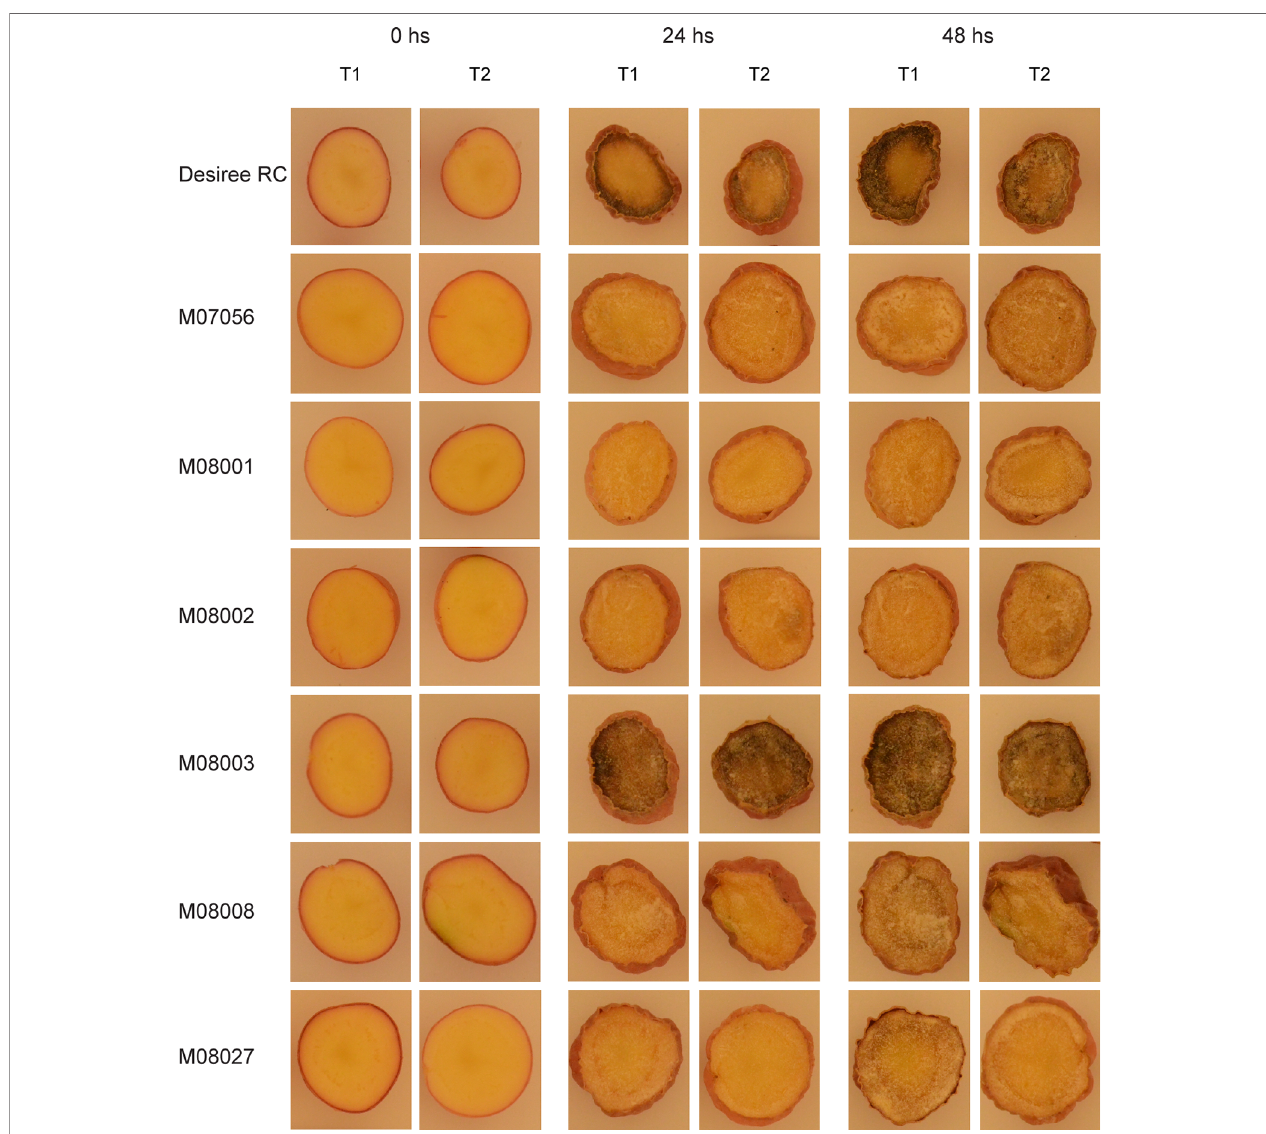
FIGURE 4 | Discoloration development of selected edited lines at times 0, 24, and 48 h after cutting. Two tubers were randomly selected for each edited line and the control, cut and exposed to the air for 48 h at room temperature (24°C). Photos were taken immediately after cutting (0hs), 24 and 48 h later. T1 and T2 indicate Tuber 1 and Tuber 2 of each line,